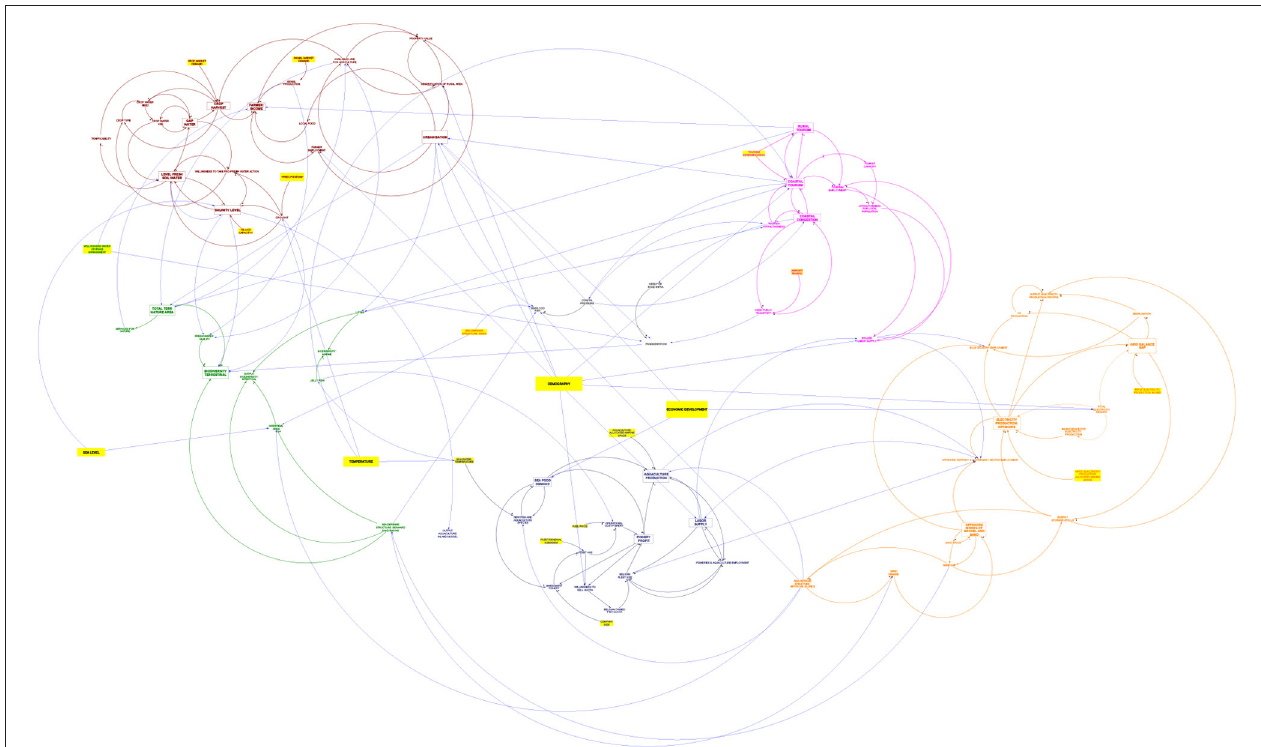
FIGURE 2 | Illustration of how complex a CLD can be after combining six sectoral workshops. The different colors represent the different sectors.